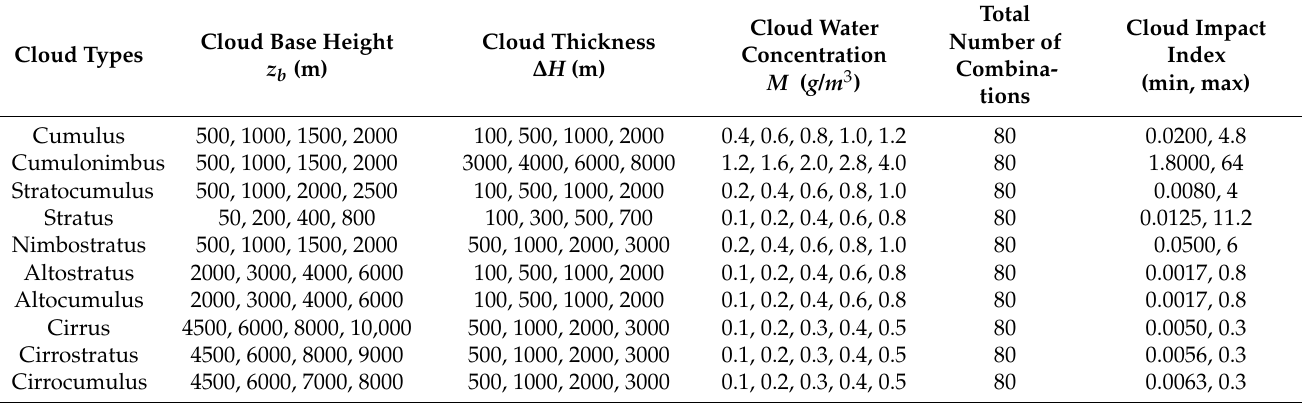
Table 1. The 800 possible combinations of cloud parameter values based on the literature.